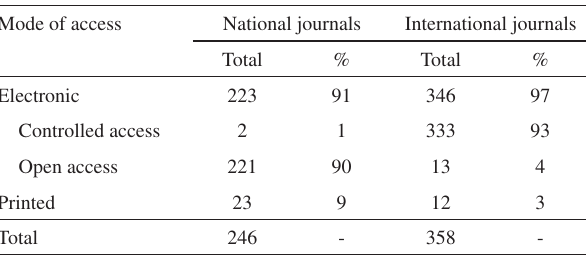
Table 2 - Articles published by authors from InCor, accord- ing to the type of journal and mode of access, from 2000 to 2003